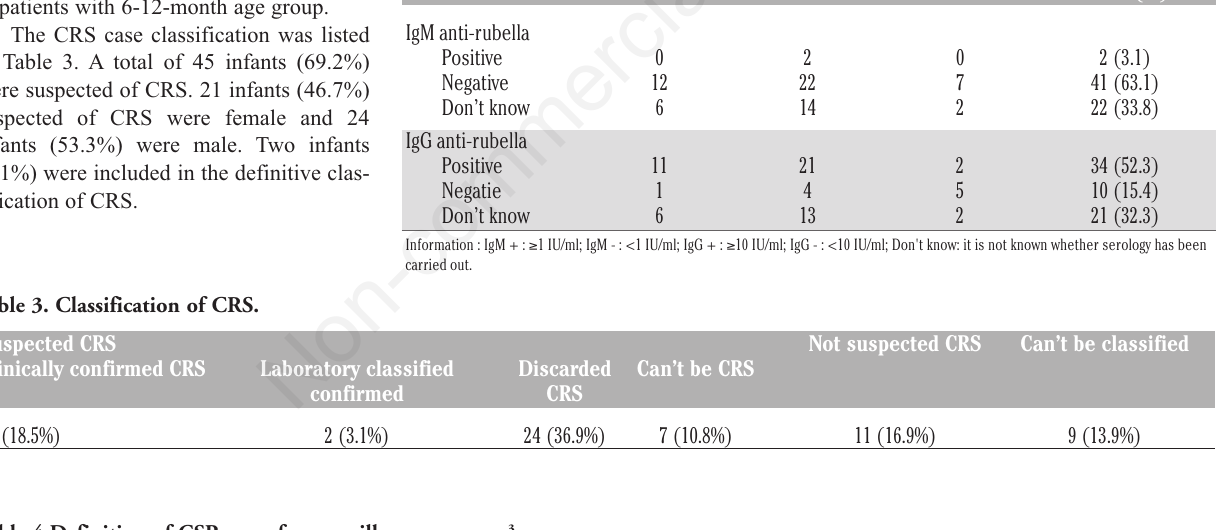
Table 4.Definition of CSR cases for surveillance purposes 3 Case